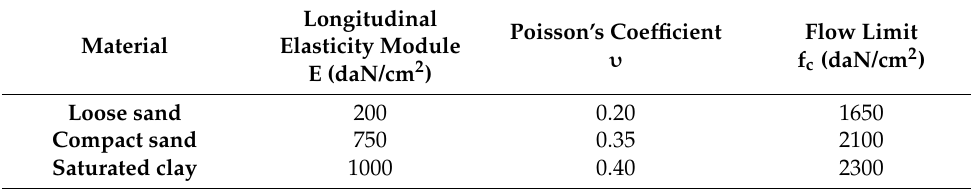
Table 2. Mechanical characteristics of foundation ground.